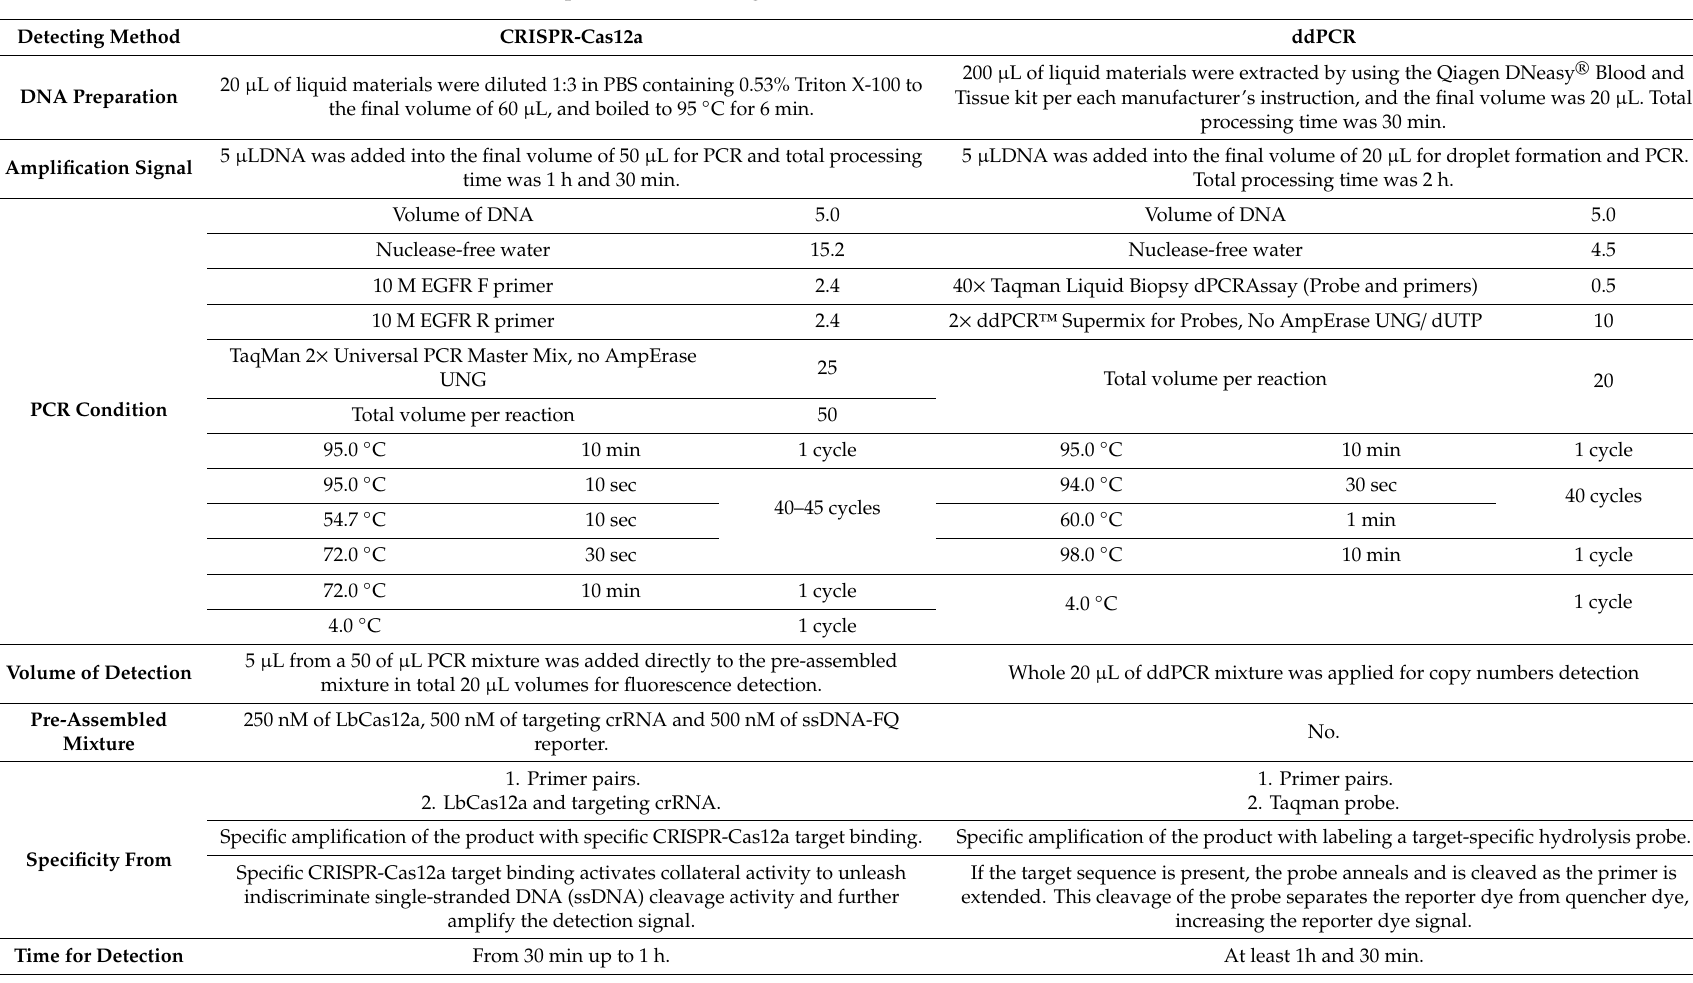
Table 3. Comparison of detecting EGFR mutations with CRISPR-Cas12a and